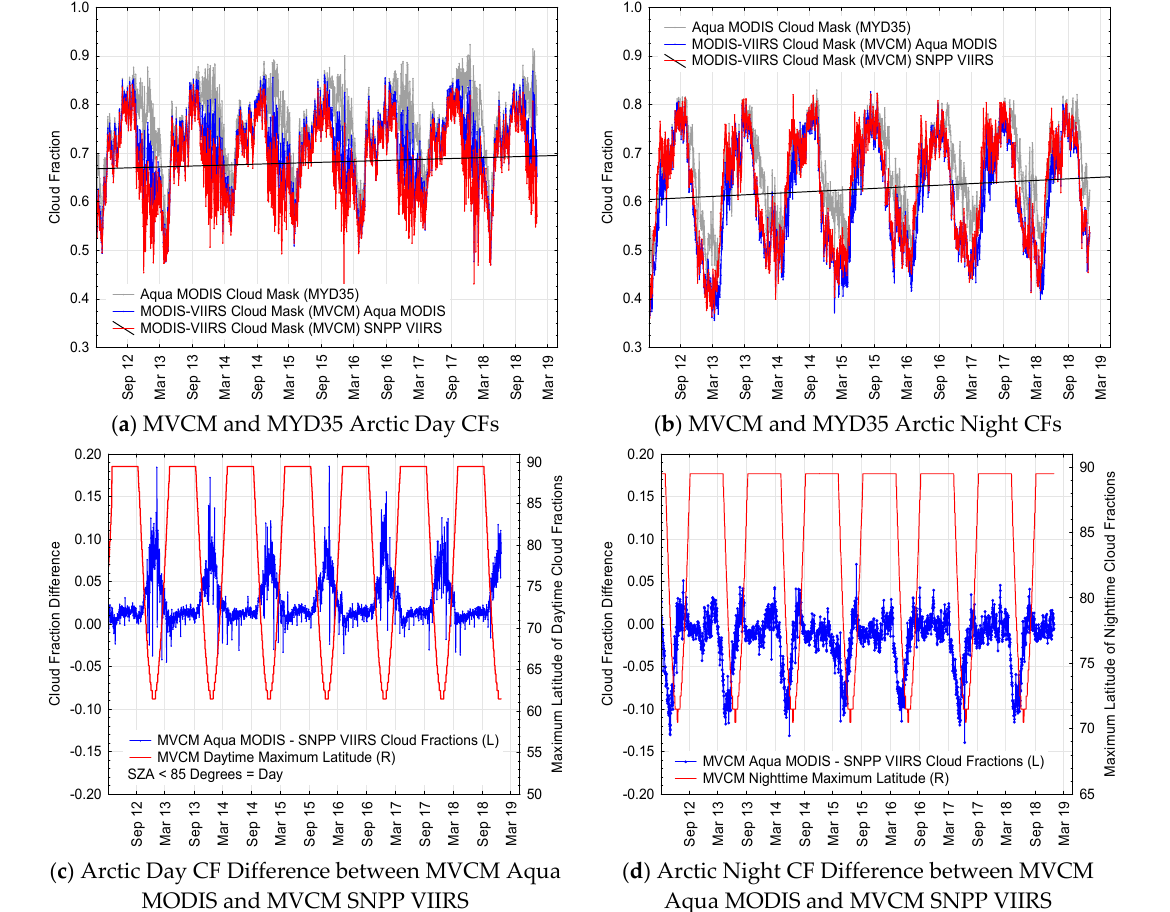
Figure 5. Time series of MVCM and MYD35 cloud detection in the Arctic (60N-90N) from the period March 2012 – December 2018; ( a ) daytime cloud fractions (CFs) for MYD35 (gray), MVCM Aqua MODIS (blue) and MVCM SNPP VIIRS (red); ( b ) nighttime CFs for MYD35 (gray), MVCM Aqua MODIS (blue) and MVCM SNPP VIIRS (red); ( c ) daytime CF differences between MVCM Aqua MODIS and MVCM SNPP VIIRS (blue lines). Red lines indicate the maximum latitude of daytime CFs recorded (scale on the right); ( d ) nighttime CF differences between MVCM Aqua MODIS and MVCM SNPP VIIRS (blue lines). Red lines show the maximum latitude of nighttime CFs (scale on the right).